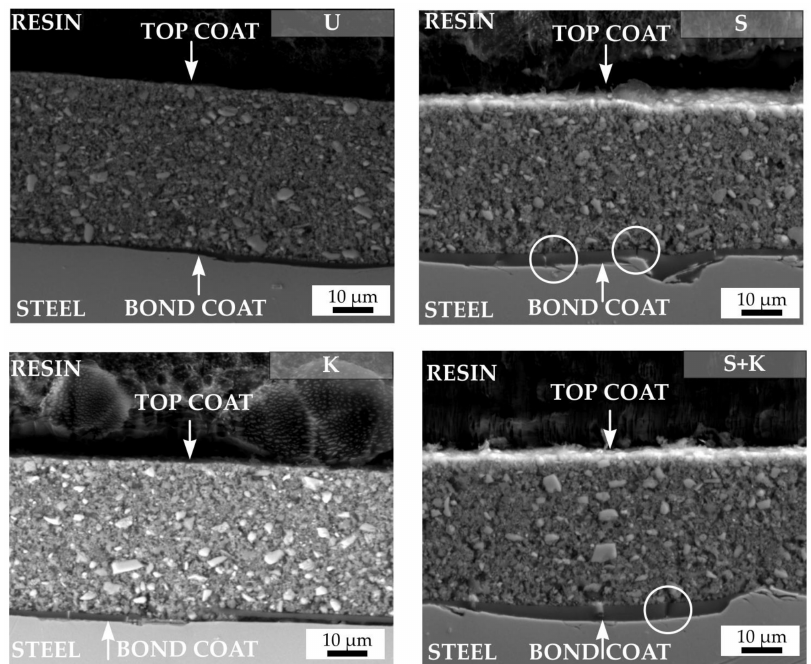
Figure 9. SEM cross sections of pyrolysed D2-PP coatings. The applied cleaning procedure is indicated